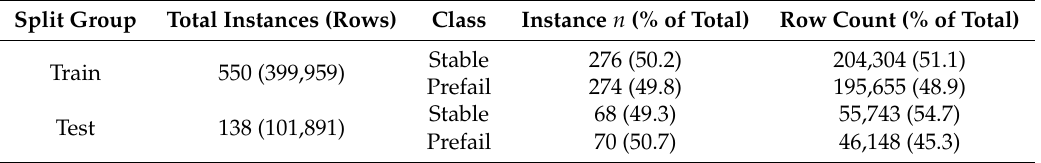
Table 3. Train/test data split description showing prefail/stable instance row counts and percentages.